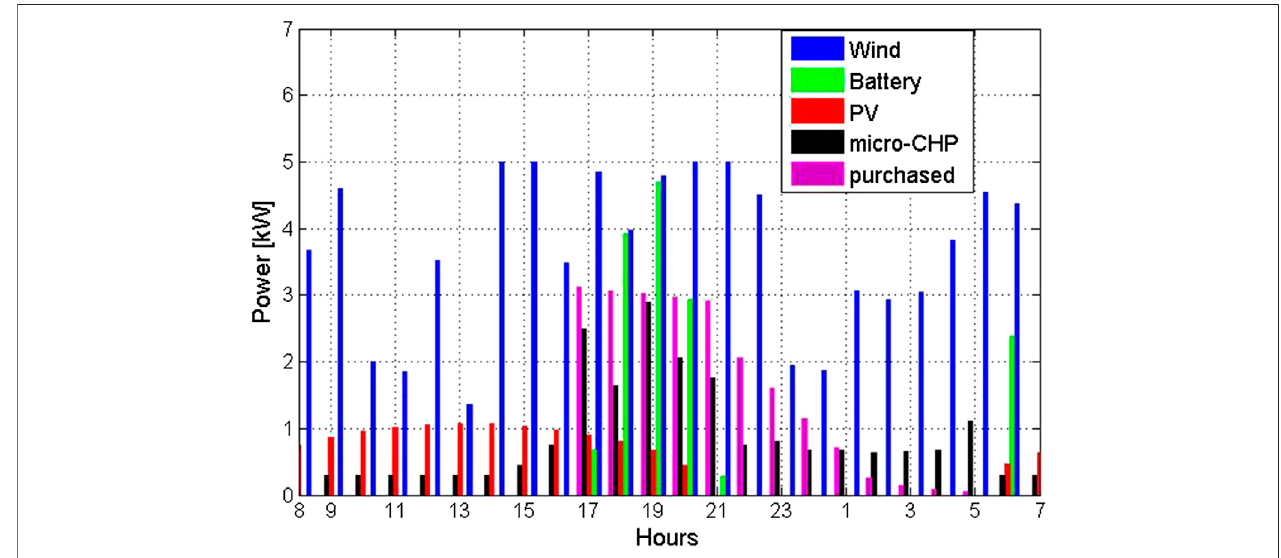
FIGURE 12 | The time-varying total electric load dispatch in the